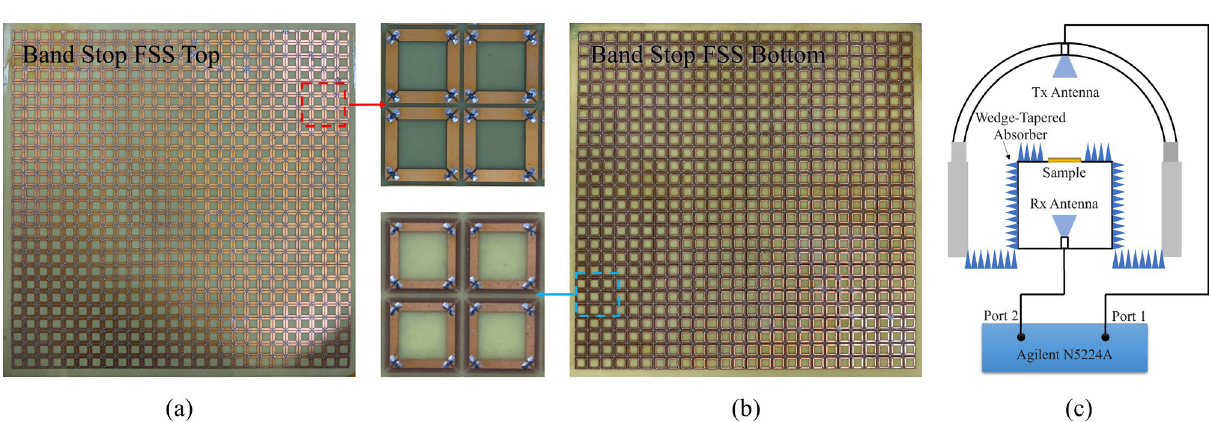
Figure 11. Photograph of the fabricated BS-FSS prototype. ( a ) Top side of the BS-FSS. ( b ) Bottom side of the BS-FSS. ( c ) Measurement setup for |S 21 |.